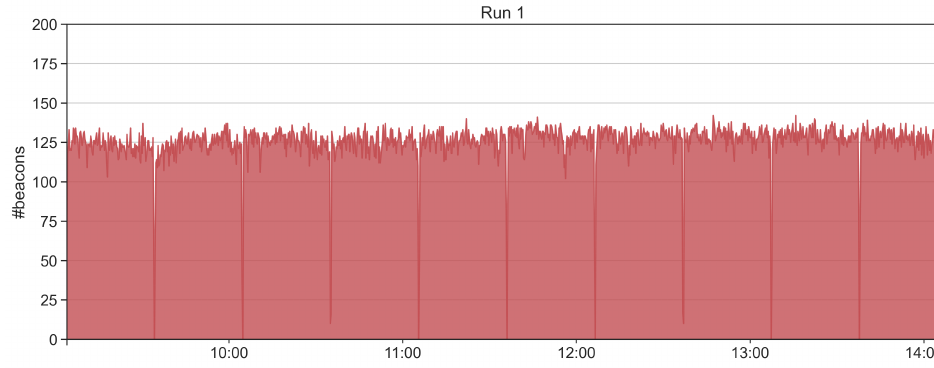
Figure 9. Cumulative number of beacons collected in T 3